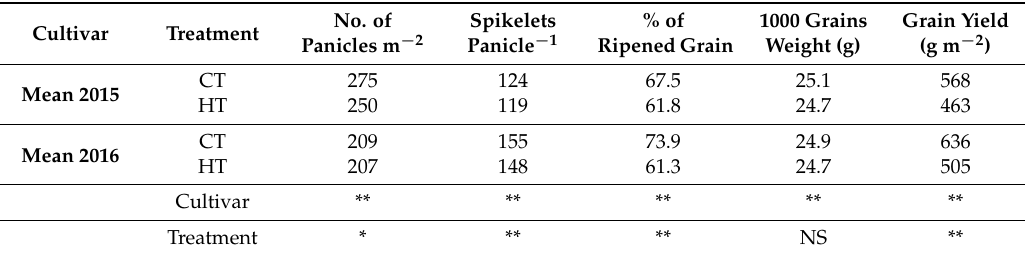
Table 1. Mean yields and yield components of Vietnamese cultivars under control and high temperature treatments in 2015 and